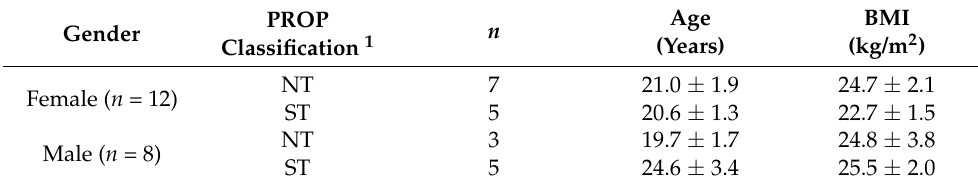
Table 1. Subject